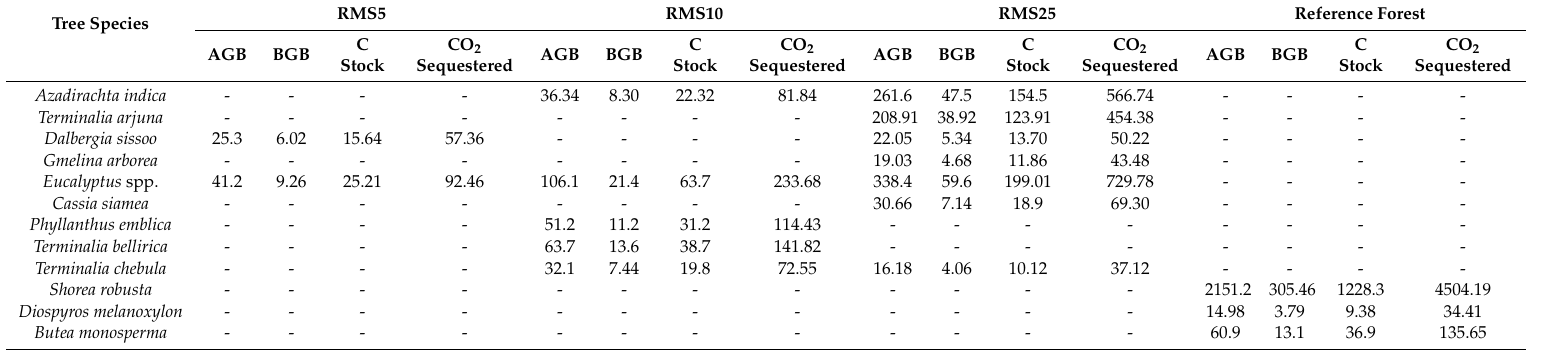
Table 2. Estimation of tree biomass (Mg ha − 1 ), tree carbon stock (Mg C ha − 1 ) and CO 2 sequestered by tree species of revegetated chronosequence dumps and reference forest.